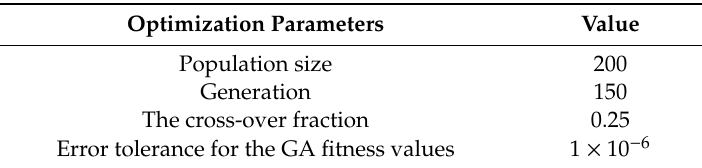
Table 5. Genetic algorithm